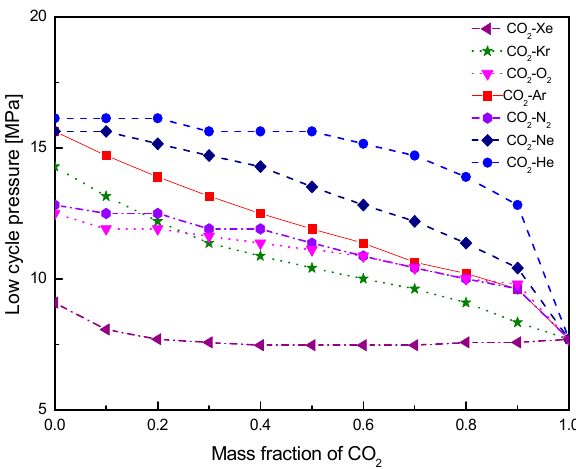
ff erent mass fractions of CO